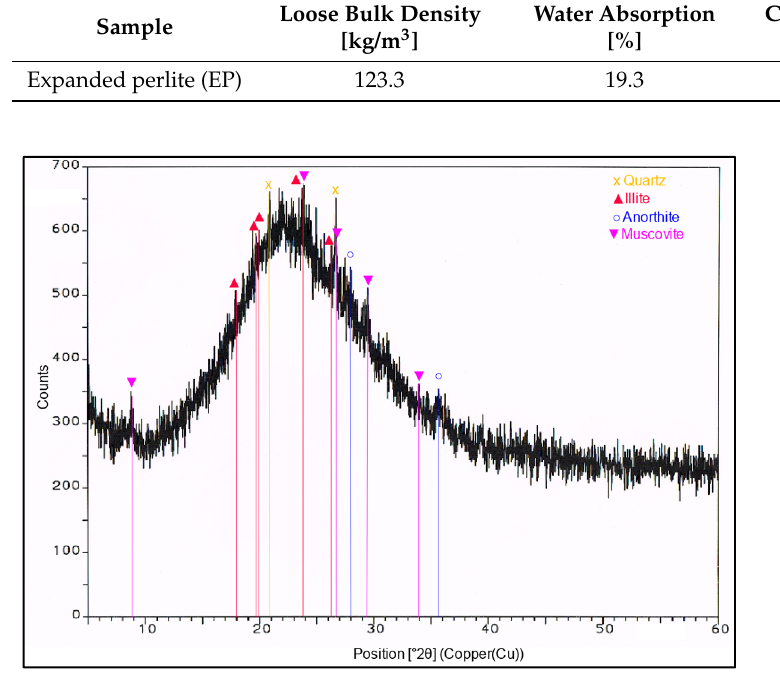
Figure 2. XRD pattern of expanded perlite.